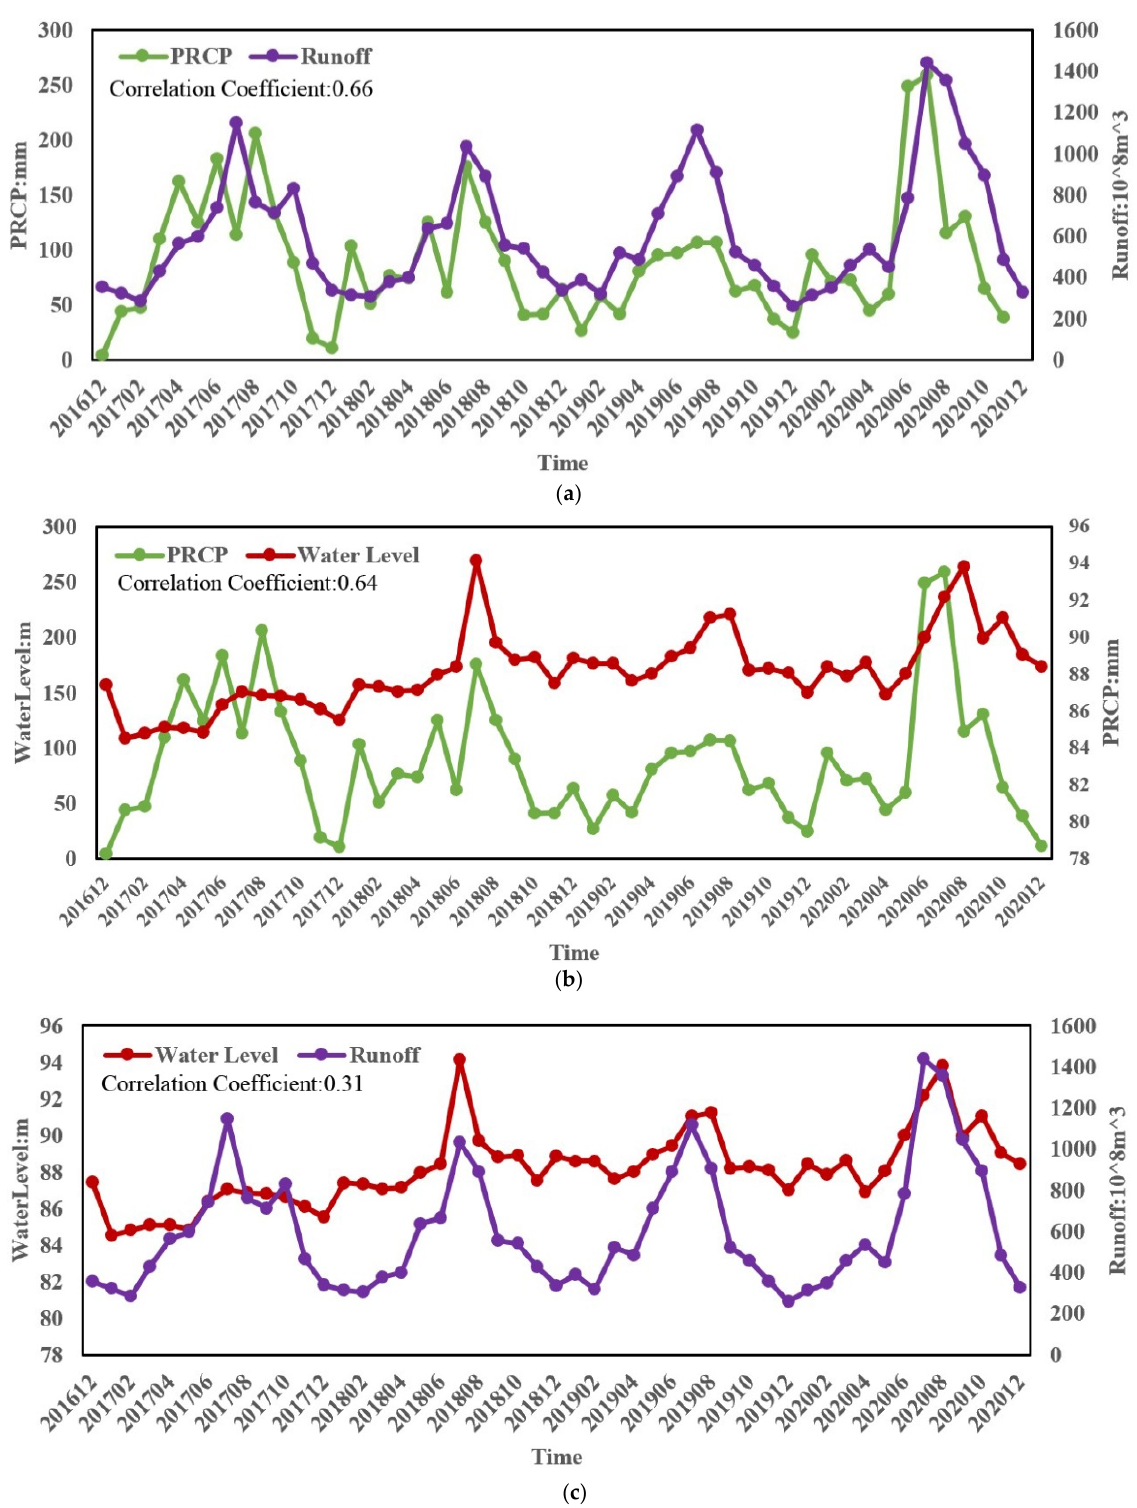
Figure 9. The relationship between runoff, water level, PRCP; ( a ) the relationship between PRCP and water level; ( b ) the relationship between PRCP and water level; ( c ) the relationship between runoff and water level. Figure 10 presents the relationships between the three driving factors of sediment runoff, water level, and precipitation in the upper reaches of the Yangtze River. There are negative correlations between the SDD and runoff, SDD and water level, and SDD and PRCP, which have correlation coefficients of −0.79, −0.62 and −0.75, respectively. During 2017–2020, the upper reaches of the Yangtze River have the lowest in summer; higher in spring, autumn, and winter than in summer, and the highest in winter, but slightly higher in spring than in winter 2020. The main reason for the rainfall being the lowest in summer is that the rainy season is from May to September every year, and the flood season of the Yangtze River is from July to August or September every year. Although the precipitation along the Yangtze River increases in summer, the temperature of the Qinghai Tibet Plat- eau in the upper reaches of the Yangtze River Basin is increasing significantly under the background of global warming due to atmospheric greenhouse effect caused by human activities. The head temperature shows an increasing trend, and the melting rate of ice and snow is accelerating [50]. The increase in surface runoff introduces a large volume of sediment, which may increase water turbidity and cause the water quality to decrease in summer. The amount of sediment runoff, water level, and precipitation in summer 2020 are significantly higher than those in summer 2017–2019, which may have been due to the increase in rainfall in the upstream area caused probably by the Hongfeng typhoon in summer 2020, which brought a large amount of precipitation and caused water pollution. The increase in water level and sediment runoff led to a decreased SDD.